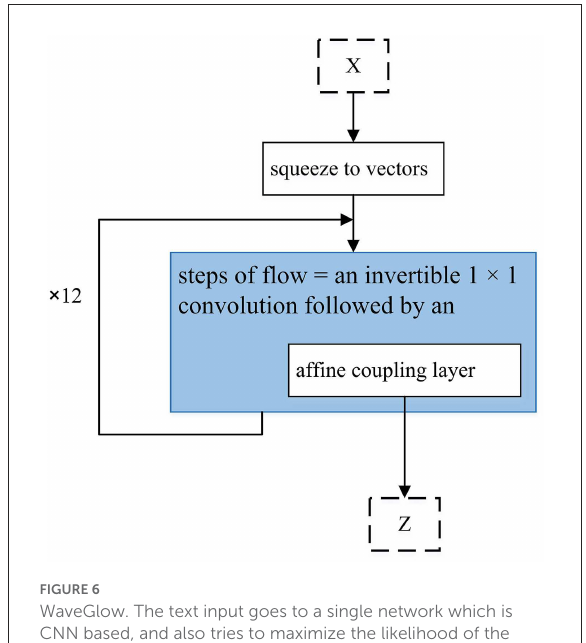
FIGURE6 WaveGlow. The text input goes to a single network which is CNN based, and also tries to maximize the likelihood of the training data, and produces the audio output. X is a group of 8 audio samples squeezed as